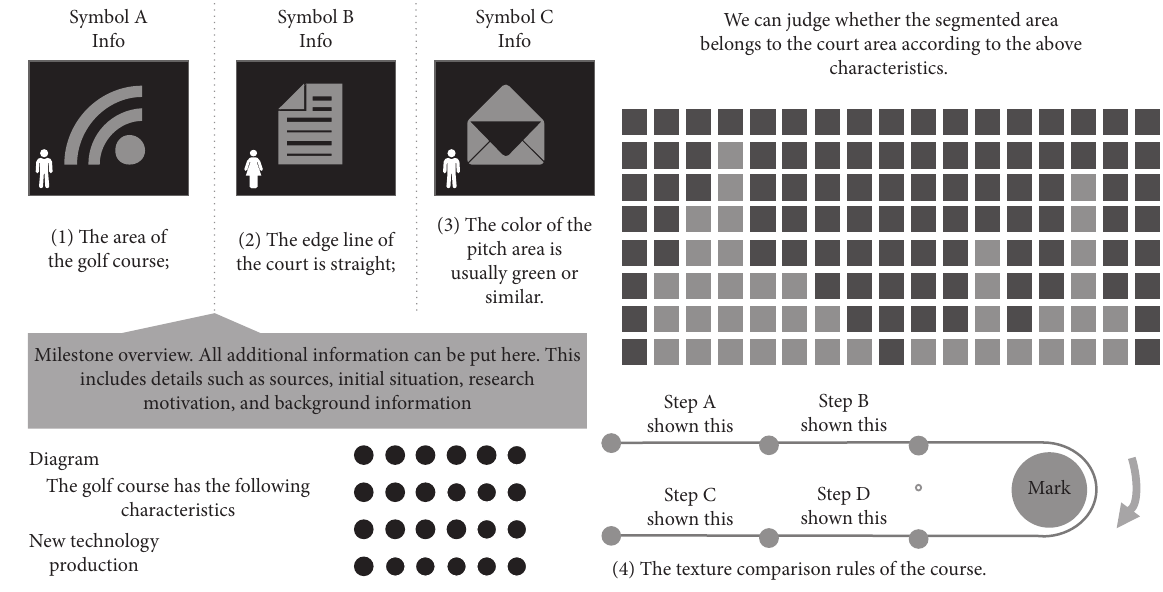
Figure 4: The extraction effect of the golf course area after